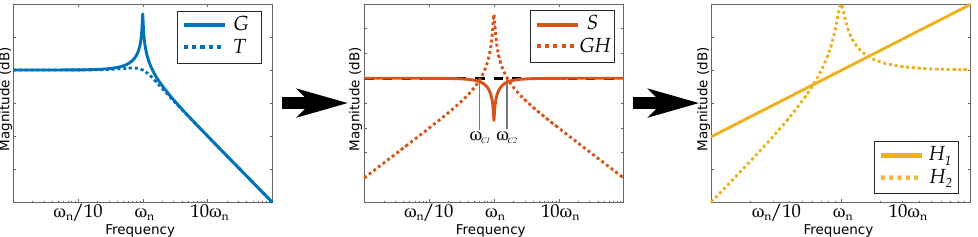
Figure 2. Illustration of the concept of loop-shaping. Using the knowledge of uncontrolled G and desired dynamics T , the necessary shapes of sensitivity S , loop gain GH and controllers can be deduced. H 1 denotes VF, while H 2 denotes NPF. Both lead to different slopes of GH